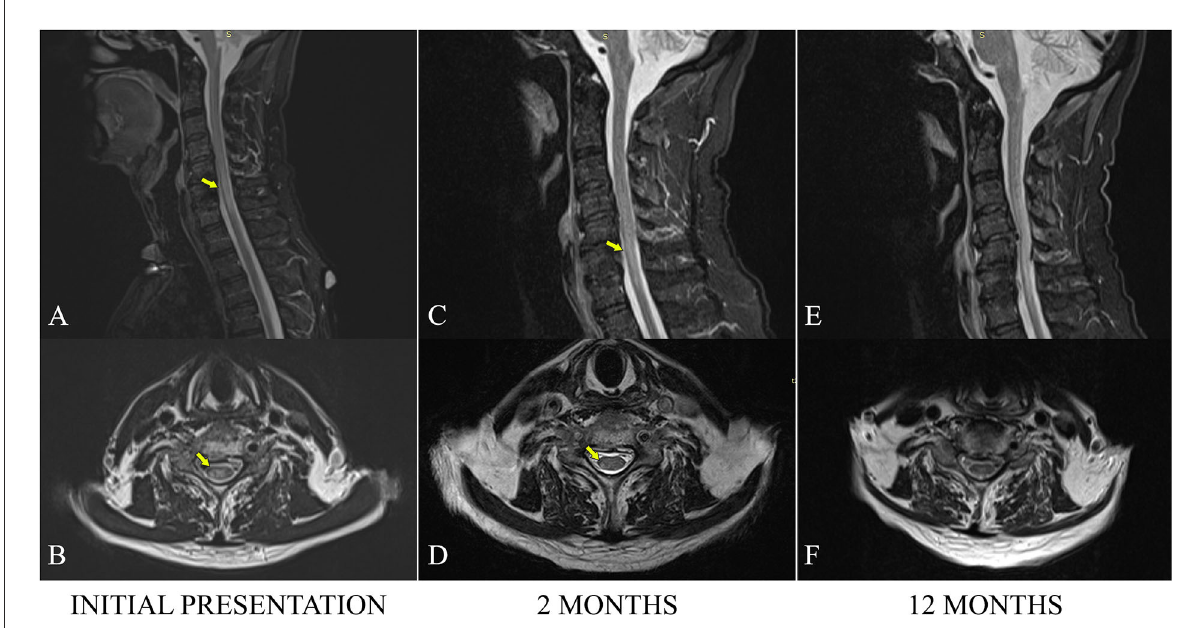
FIGURE1 Sagittal MRI STIR sections of the cervical spine at admission (A) , 2 months (C) , and 12 months (E) . Axial MRI TSE sections at approximatively the same level (a plane passing through the upper C6 plateau) at admission (B) , 2 months (D) , and 12 months (F) . The hyperintense STIR cervical lesion is visible, extending from C4 to C7. Progressive fading of the increased signal is visible over time, especially on the axial